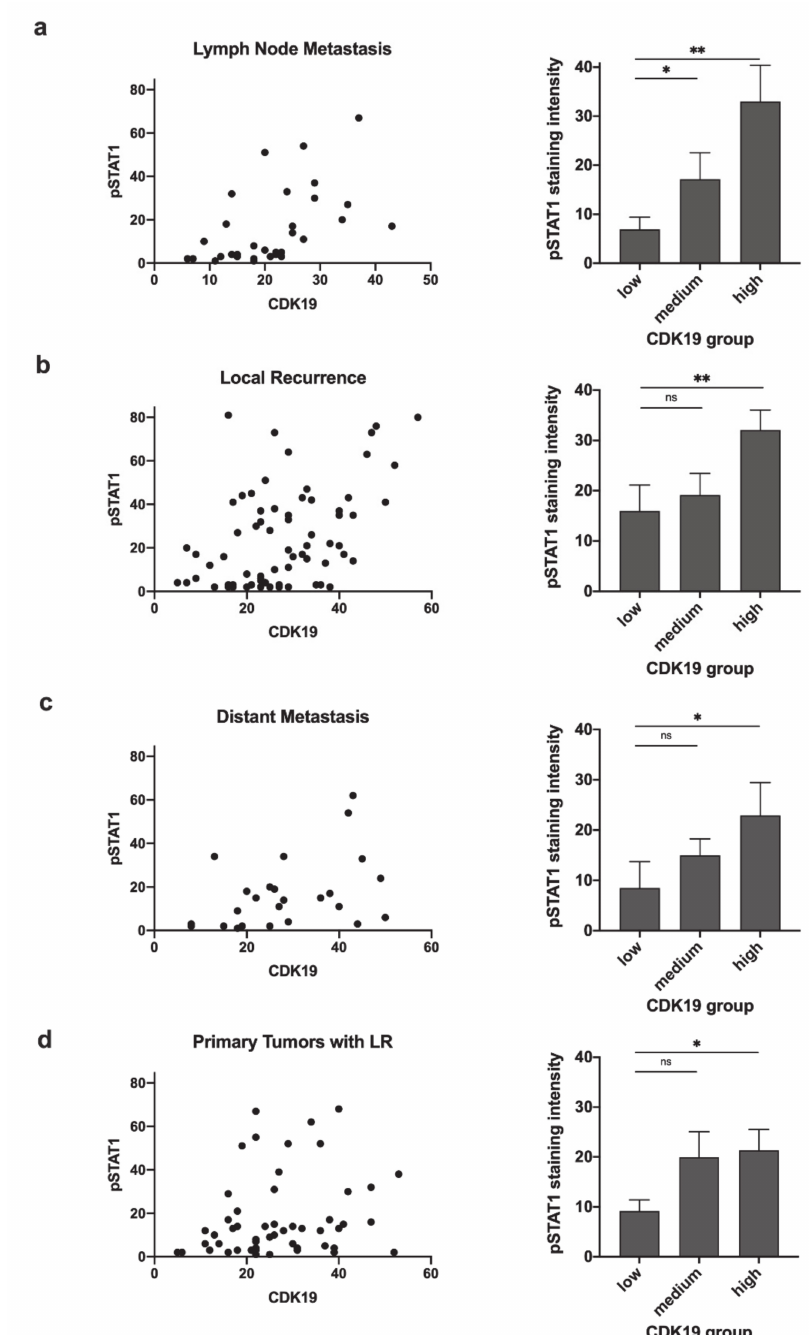
Figure 6. CDK19 expression correlates with pSTAT1 expression. Scatter plots and bar graphs illustrate the relationship between CDK19 expression and pSTAT1 expression in tissue of ( a ) LMs, ( b ) LRs, ( c ) DMs, and ( d ) PTs developing local recurrence after initial therapy. ns = not significant; * p < 0.05; ** p <